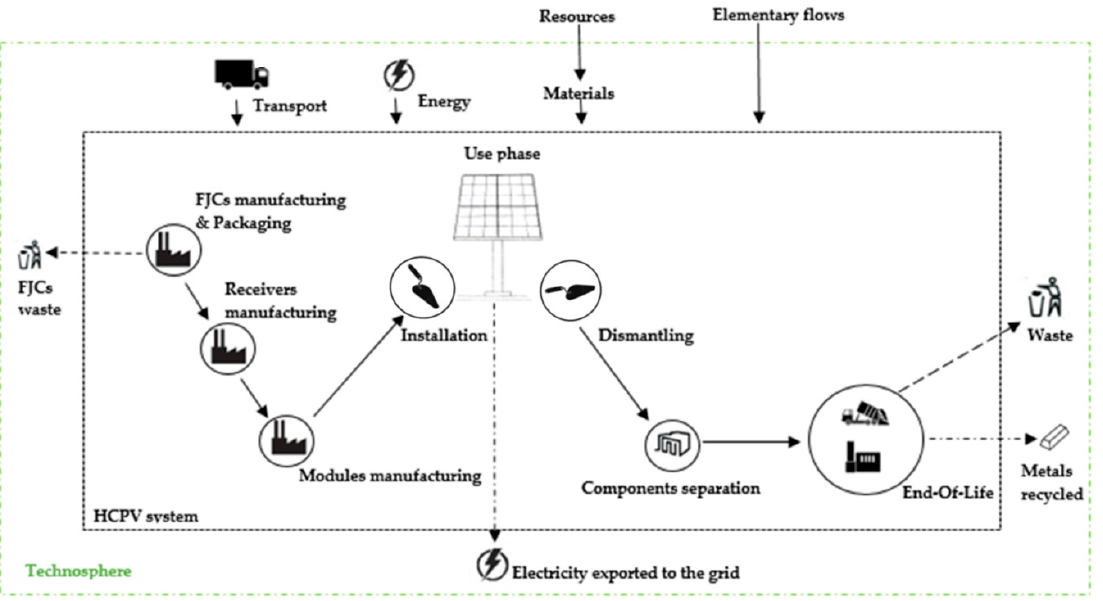
Table 2. End-of-life processes for materials and corresponding unit flows selected in ecoinvent. Materials